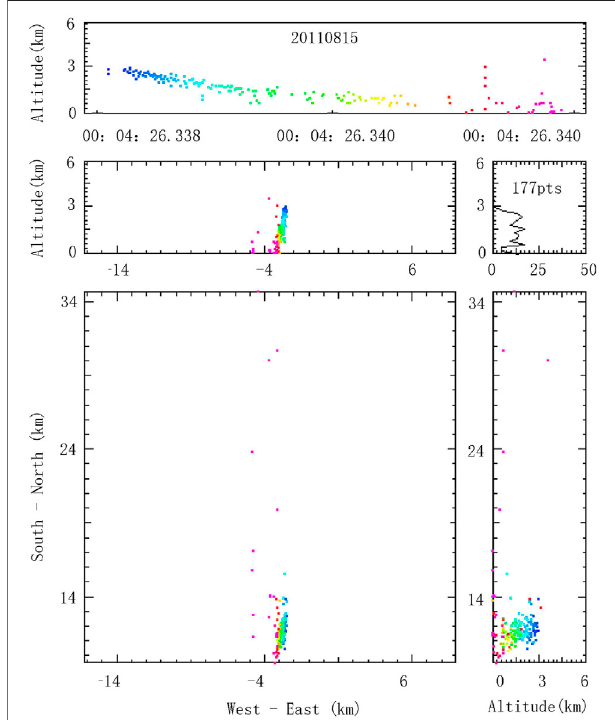
FIGURE 7 | RPBs (dart-stepped leader) in a